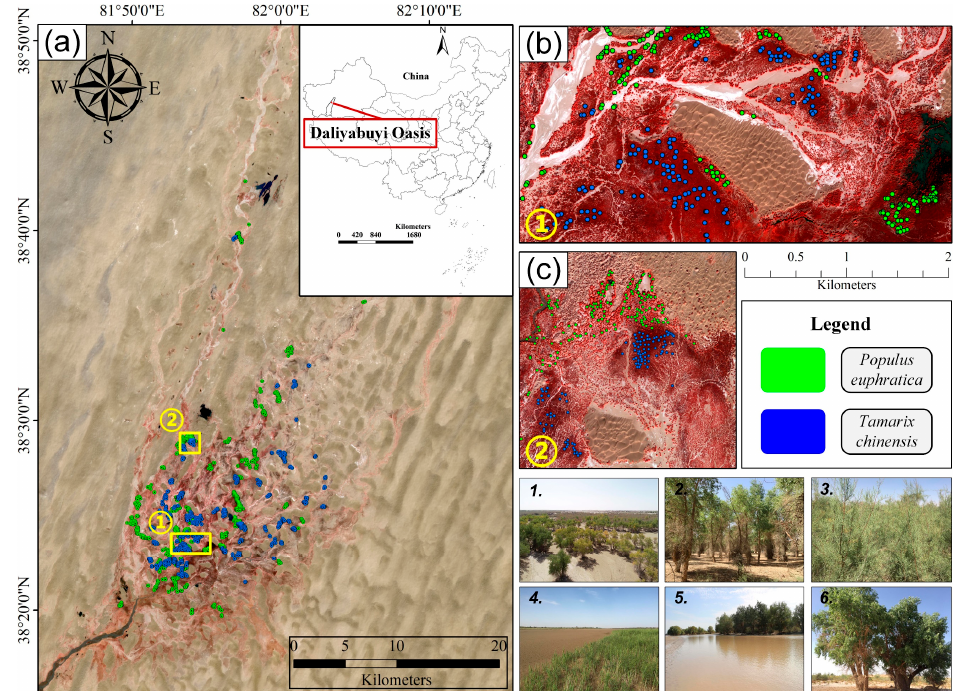
Figure 1. Location of the study site. ( a ) Pure pixels of Populus euphratica and Tamarix chinensis in a Sentinel-2 image acquired on 26 April 2020; the band combination is 8/4/3. ( b ) and ( c ) Pure pixels in a Gaofen-2 (GF-2) image acquired on 19 September 2018; the band combination is 4/3/2. (1–6) main land cover in the study site.